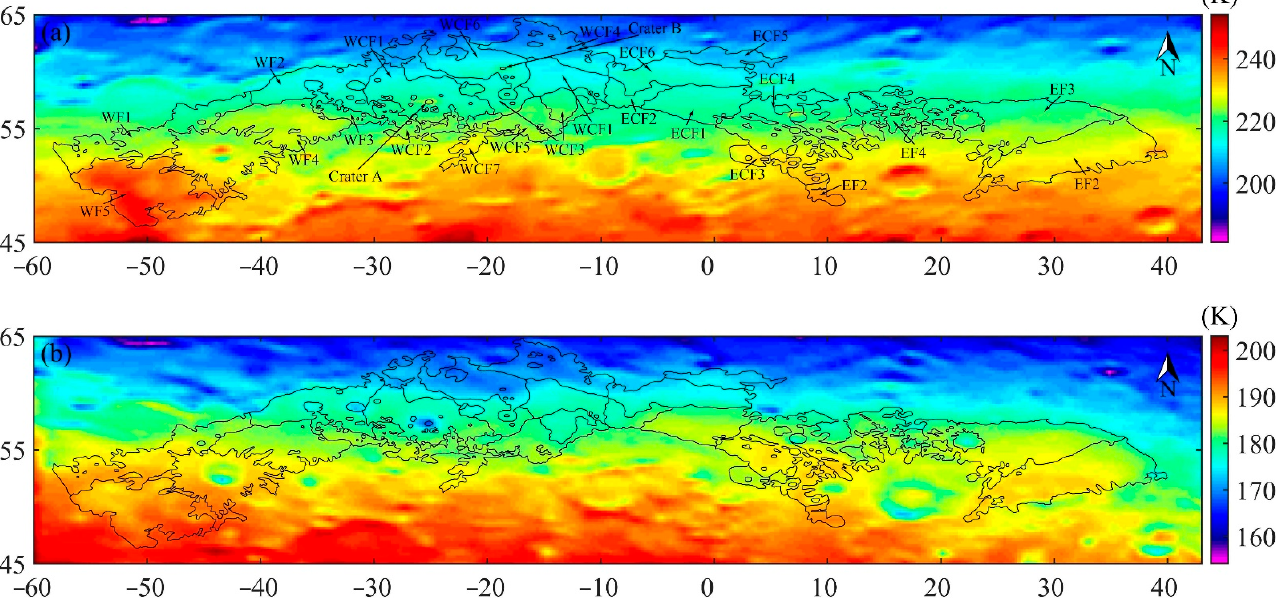
Figure 3. TB maps of Mare Frigoris at 37 GHz (equidistant cylindrical projection): ( a ) noon and ( b ) night. The black lines are the geologic boundaries of Mare Frigoris mapped by Kramer et al. [2].